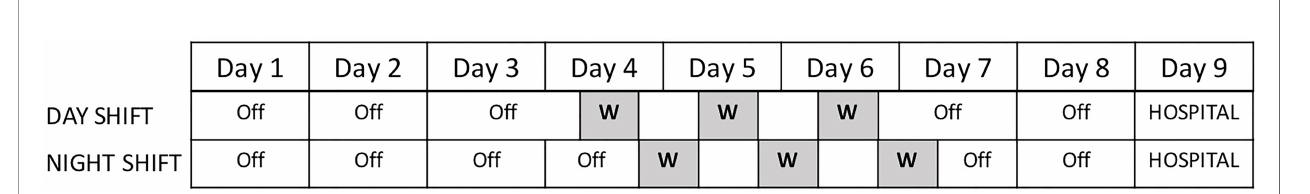
FIGURE 1 | Nine-Day Testing Protocol. Nurses were scheduled to work three consecutive 12-h shifts (greyed out). Nurses tracked their food intake during their work period starting at the beginning of their fi rst work shift through the end of their last work shift. Nurses were admitted for a 24-h hospital stay beginning on the morning of day